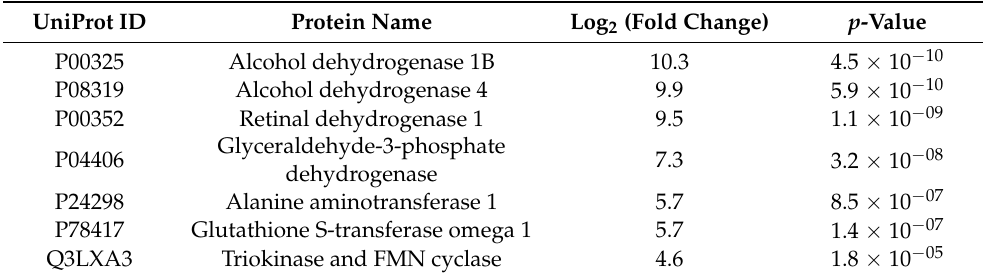
Figure 1. Bioinformatics selection and proteomics discovery of liver injury biomarker candidates: ( a ) Principle and selection criteria to select biomarker candidates for hepatocyte cell death poten- tially detectable in plasma. ( b ) Label-free quantitative proteomics analysis of serum samples from acetaminophen-induced ALI patients and healthy donors to verify the leakage of biomarker candi- dates into the blood. Table 1. Biomarker candidates for hepatocyte cell death selected using the bioinformatics workflow that are significantly increased in serum samples from acetaminophen-induced ALI patients ( n =